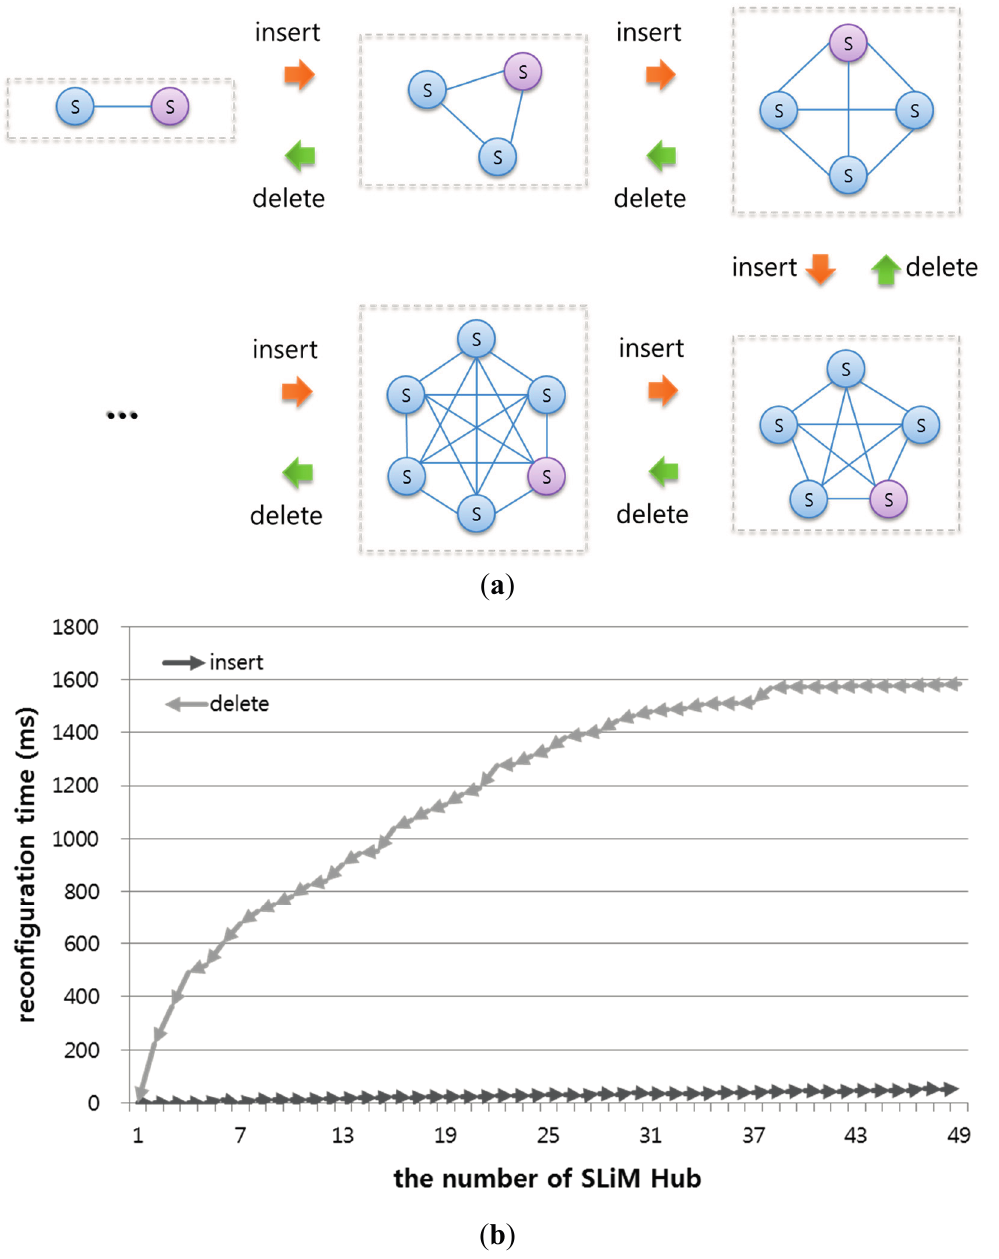
Figure 20. Reconfiguration evaluation from inserting or deleting SLiM Hubs. ( a ) Process of inserting or deleting one SLiM Hub for fully connectivity. ( b ) Reconfiguration times when inserting or deleting up to 50 SLiM